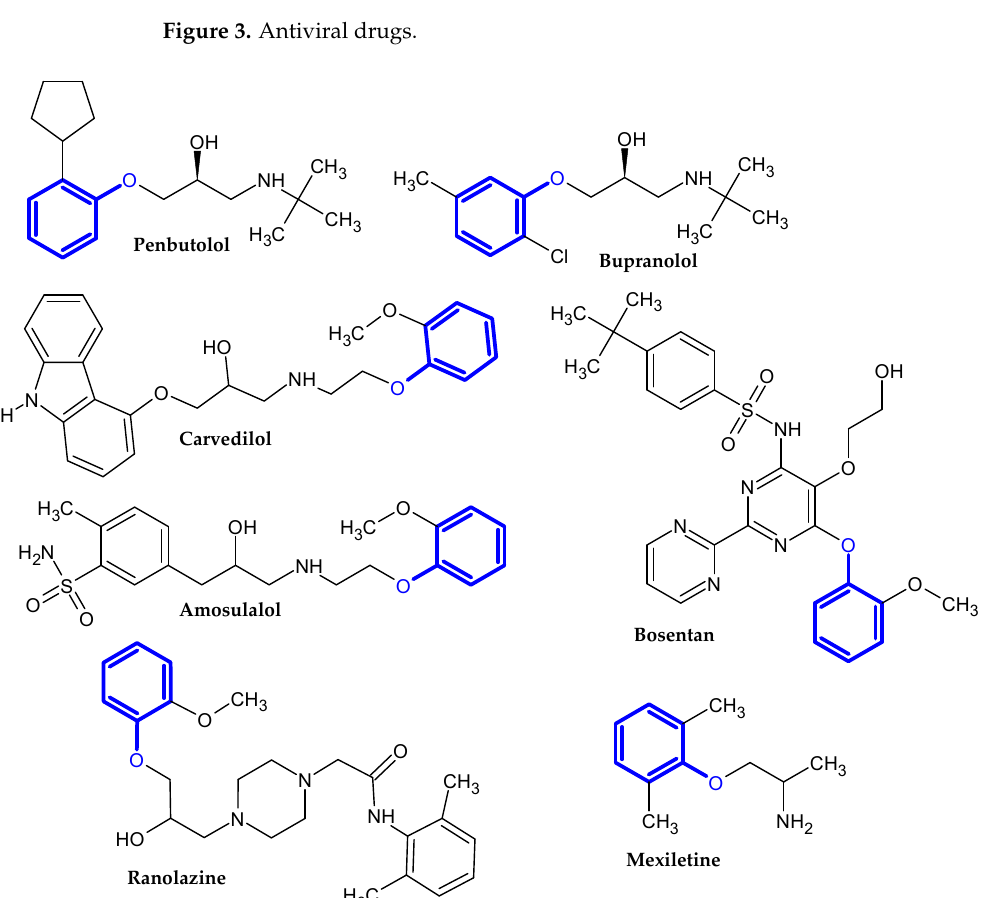
Figure 4. Cardiac drugs.